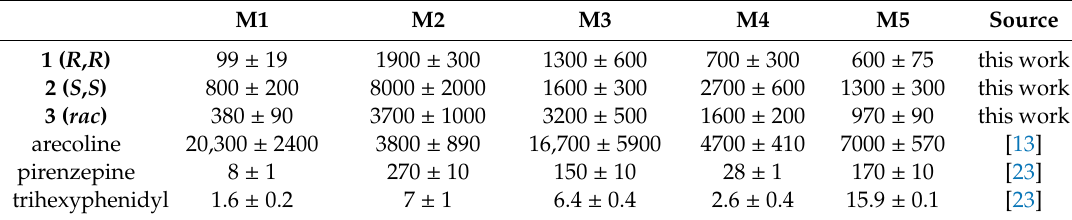
Table 1. Inhibition constants (K i ) given in nM, determined by competition binding on cell membranes derived from Chinese hamster ovary (CHO) cells. For data of this work and [13], errors are reported as standard deviation and for [23], errors are reported as standard error. K i values of this work were